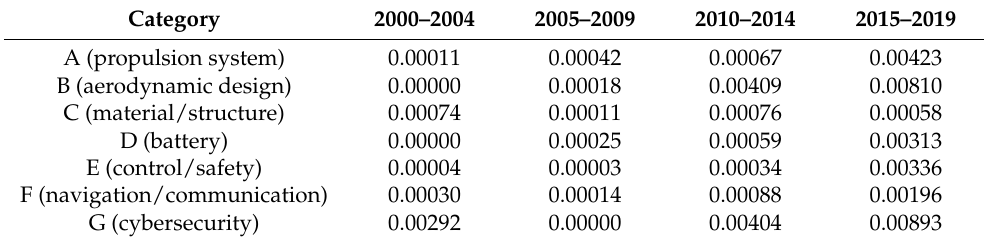
Table 14. Betweenness centrality by technology.